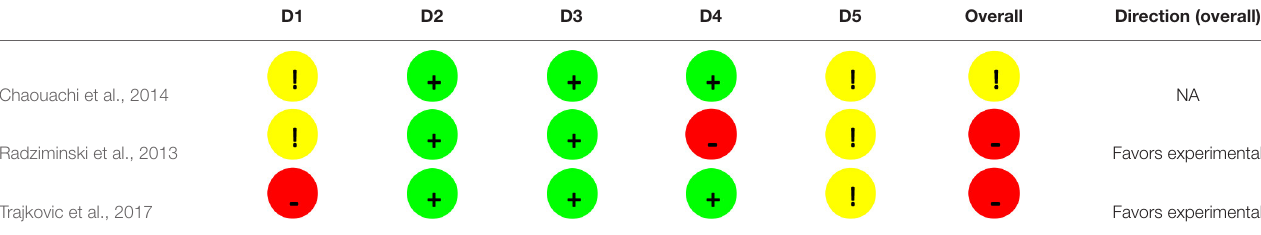
TABLE 2 | Assessment of risk of bias of randomized trials with The Risk of Bias 2 (RoB2).